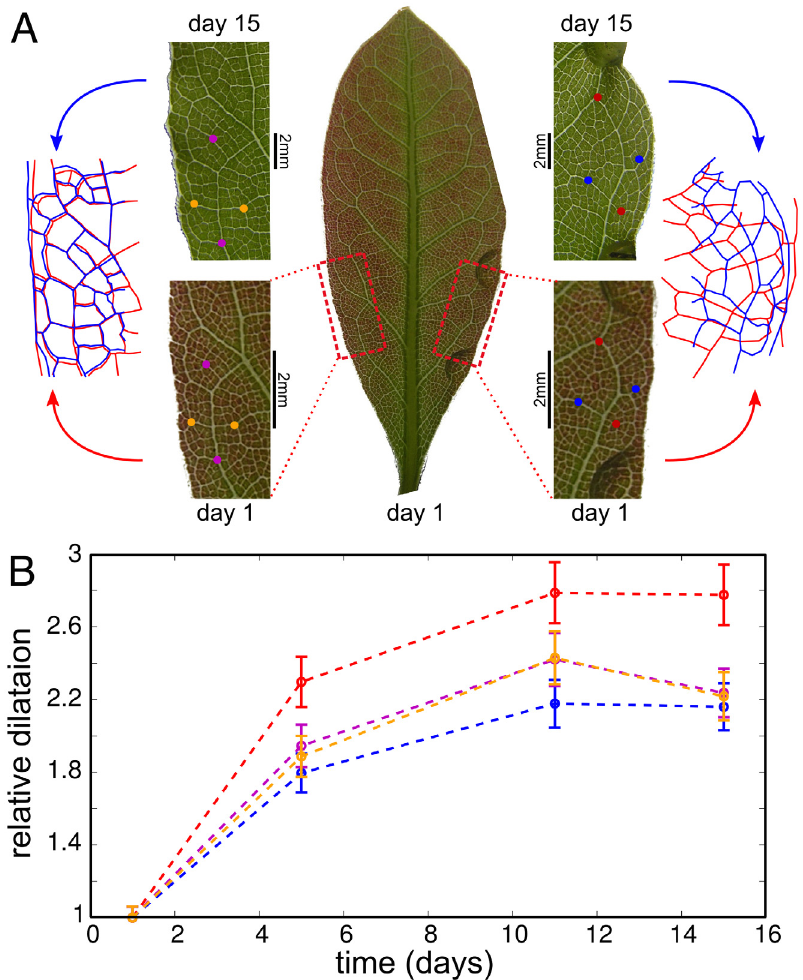
Fig 4. Stretching leaves: Tracing of the venation pattern throughout growth. The transparent drops visible in panel (A) are epoxy glue. The tensile force was applied between these points. The distance between the stretching points is 3.5mm on day 1 and 9.3mm on day 15. In panel (a) we plot the locations of the stretched (right) and freely-grown (left) regions in the leaf on day 1. A close up shows that the freely- grown region grew by isotropic expansion, while the stretched region grew anisotropically (note the different scales for day 1 and day 15). This is confirmed by superimposing the rescaled venation patterns from day 1 (red) and day 15 (blue). (B) Quantification of the large scale anisotropy of growth: The elongation of two perpendicular segments in each region. The endpoints of each segments are marked by colored points in panel (A), and the same color code is used in panel (B). The length of each segment is normalized by its initial value.